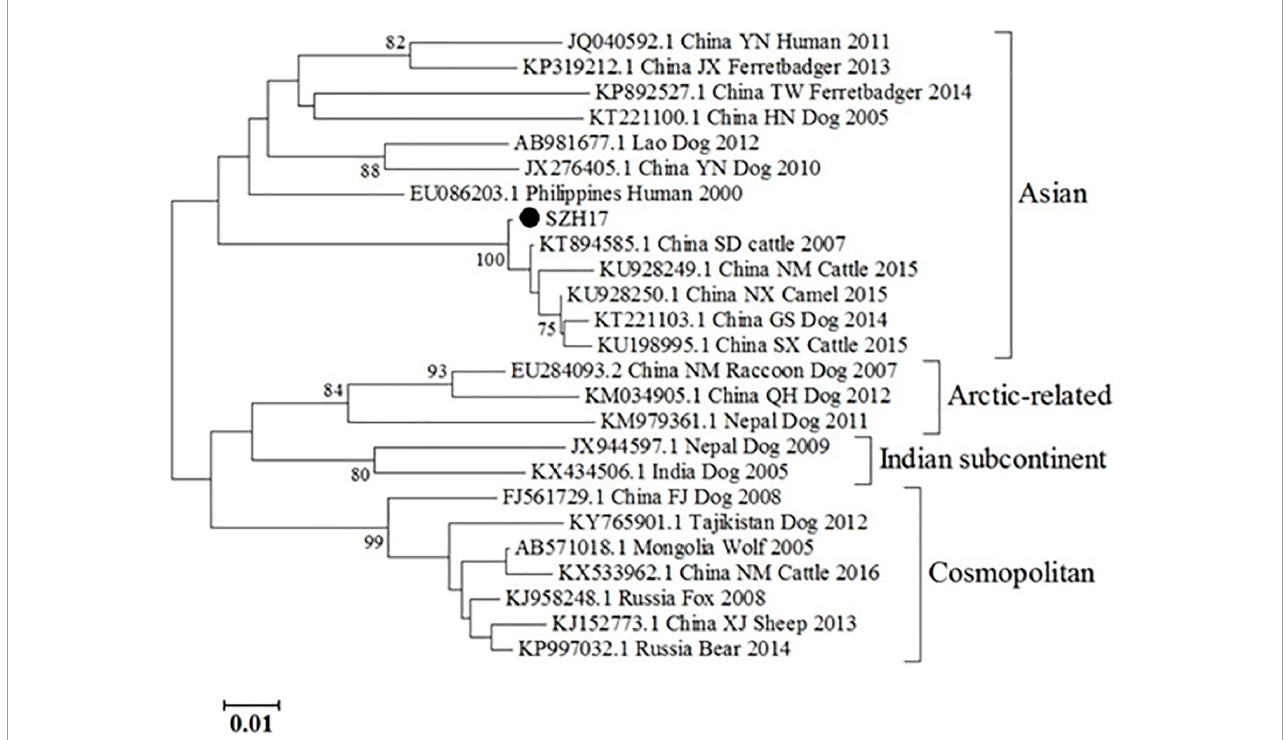
FIGURE2 Phylogenetic analysis of RABVs. SZH17 was the RABV strain from the patient in this